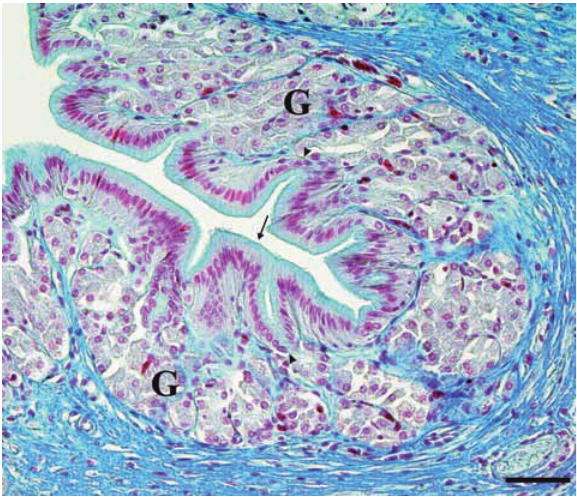
Fig . 1. – Morphology of the gastric mucosa of Halobatrachus di- dactylus . the tunica mucosa is lined with a simple columnar epi- thelium and shows gastric pits at the base of which gastric glands open. Masson trichrome staining. G, gastric gland; arrow, surface epithelial cells; arrowhead, pit cells. Scale bar: 37